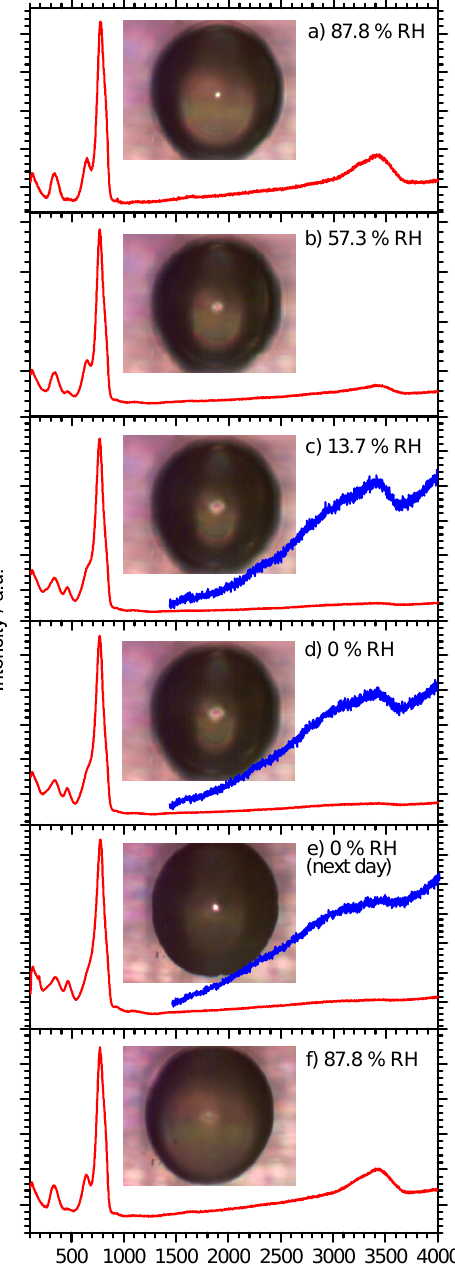
Fig. 3. Raman spectra of deliquesced HIO 3 on decreasing RH (a– d) and then increasing RH again on the following day (e–f) after leaving the droplets at 0% RH overnight. The spectra are for the same droplet as in Fig. 2, but tests demonstrated that all droplets ( ∼ 30 droplets) on the slide responded in a similar manner. The OH stretch band associated with water ( ∼ 3400cm − 1 ) decreases dra- matically on reducing RH, but the droplet does not revert back to its crystalline form. The blue expanded spectra are included only in cases where the OH band is weak. The width of the microscope images is